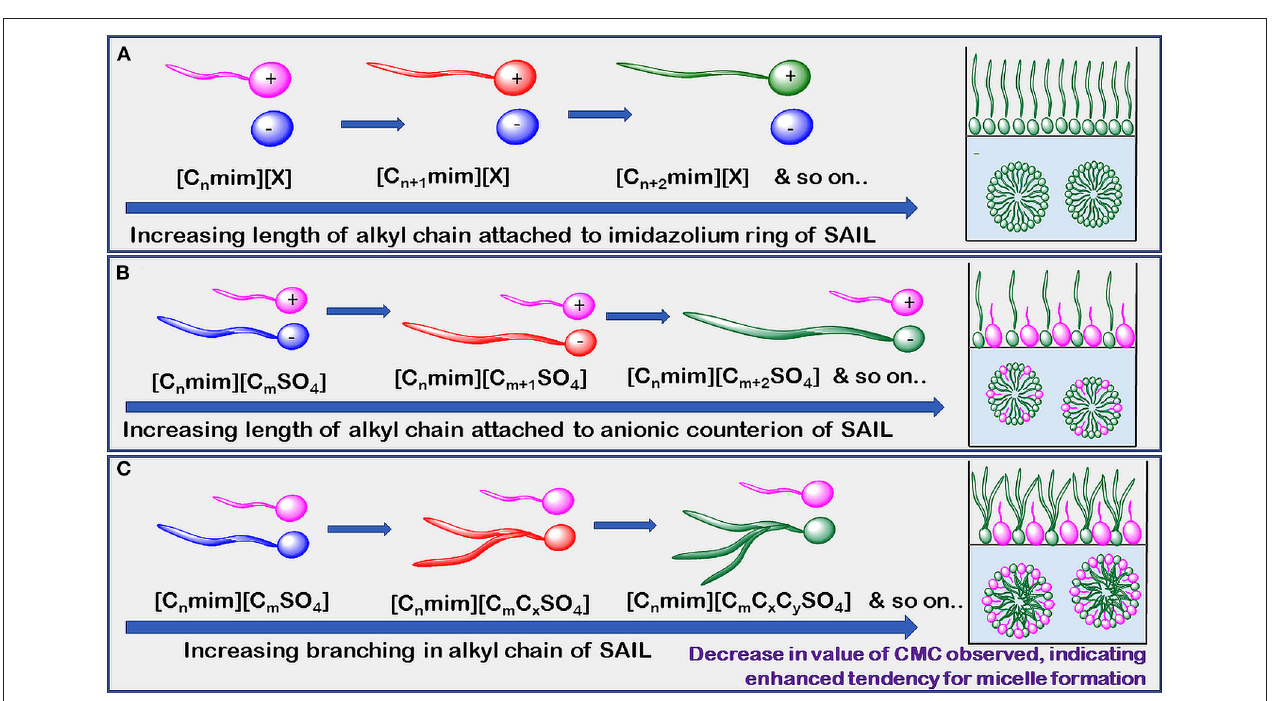
FIGURE 8 | Schematic diagram of CMC (mM) variation by increasing length of alkyl chain attached to (A) imidazolium ring of SAIL (B) anionic counterion of SAIL and (C) branching of